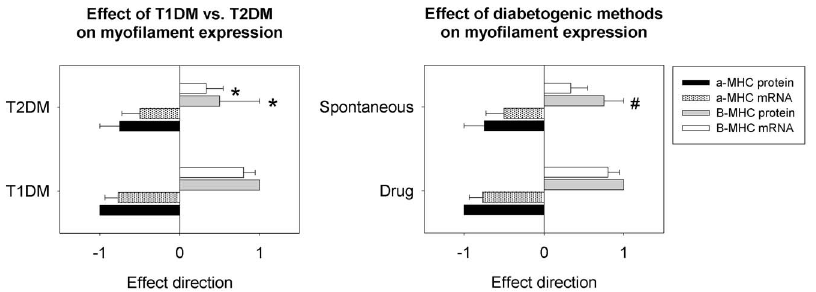
Figure 5. Effect of diabetes type and methods of diabetogenicity on cardiac myosin expression. The type of diabetes and the method of inducing diabetes significantly affect the expression of myosins in the hearts of experimental rodent models of diabetes. * significant effect of diabetes type; # significant effect of diabetogenic category. Significance set at P , 0.05. T1DM = type 1 diabetes mellitus; T2DM = type 2 diabetes mellitus.